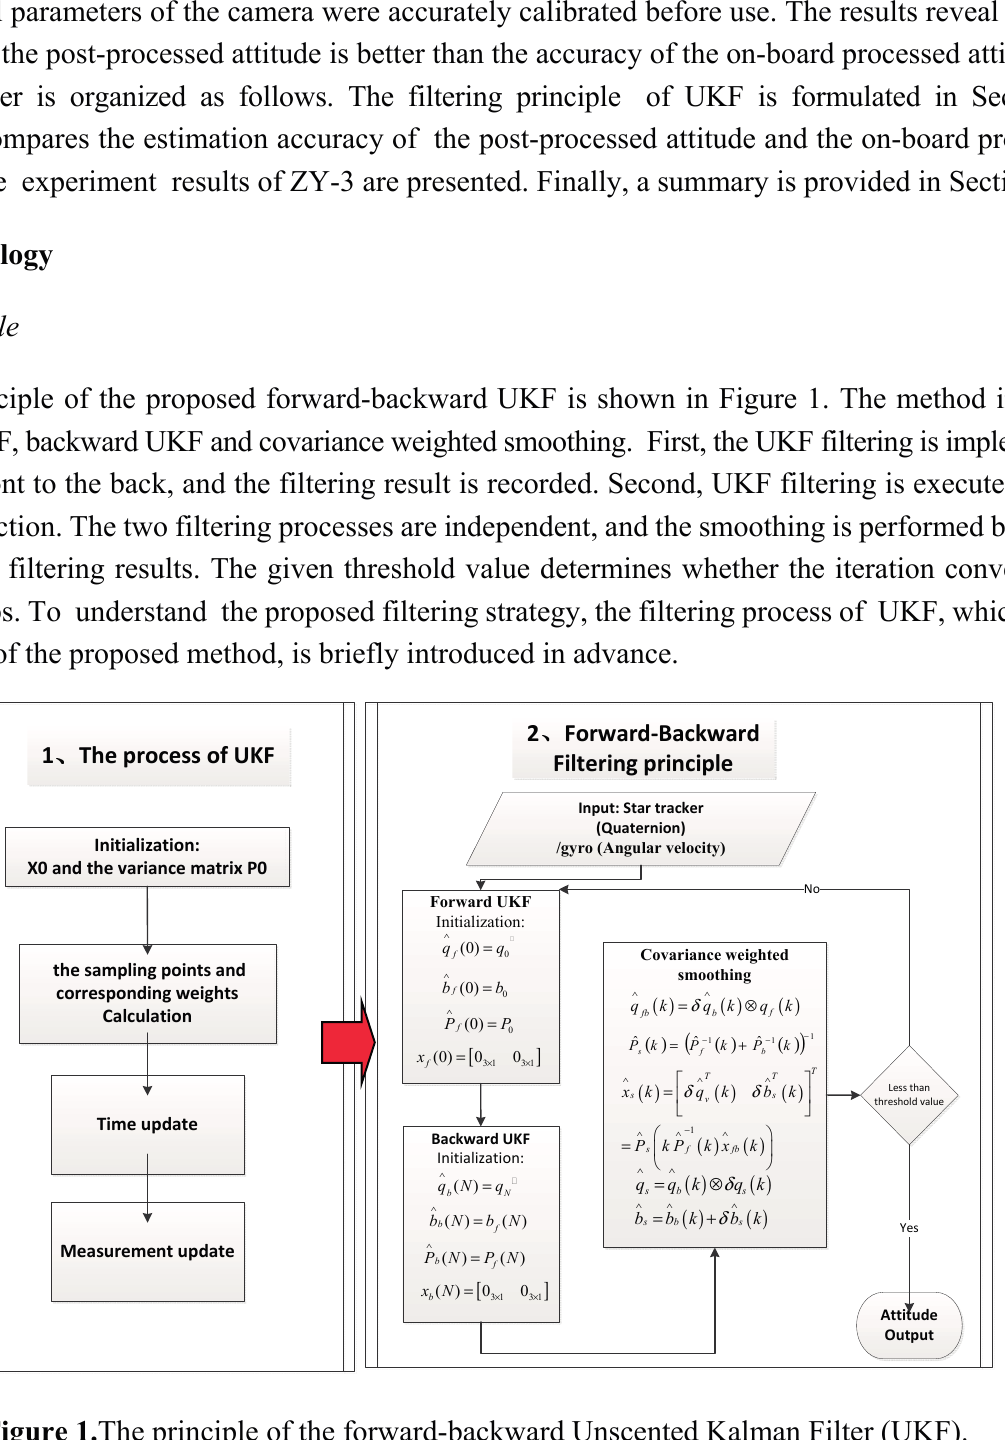
Figure 1. The principle of the forward-backward Unscented Kalman Filter